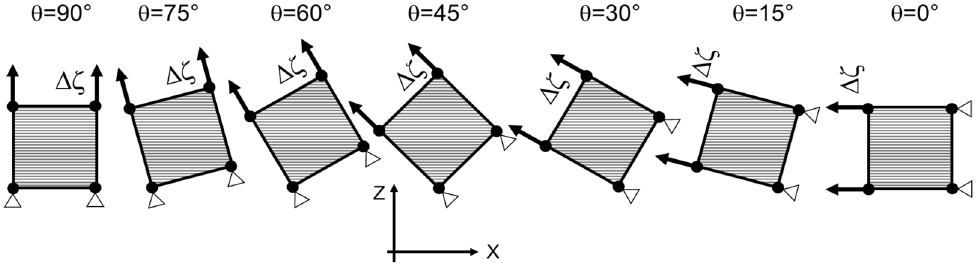
Figure 7. Numerical model configurations used for material model evaluation.